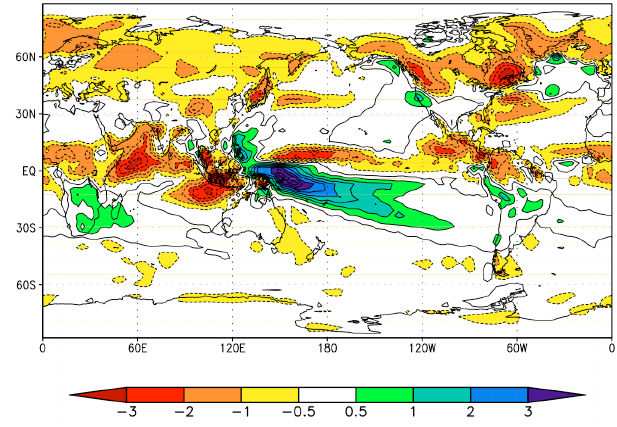
Fig. 10. The change in annual mean 2m air temperature LGM-PI ( ◦ C). Note the irregular contour intervals. Figure 10. The change in annual mean 2m air temperature LGM-PI (°C). Note the irregular 3 contour intervals. 4